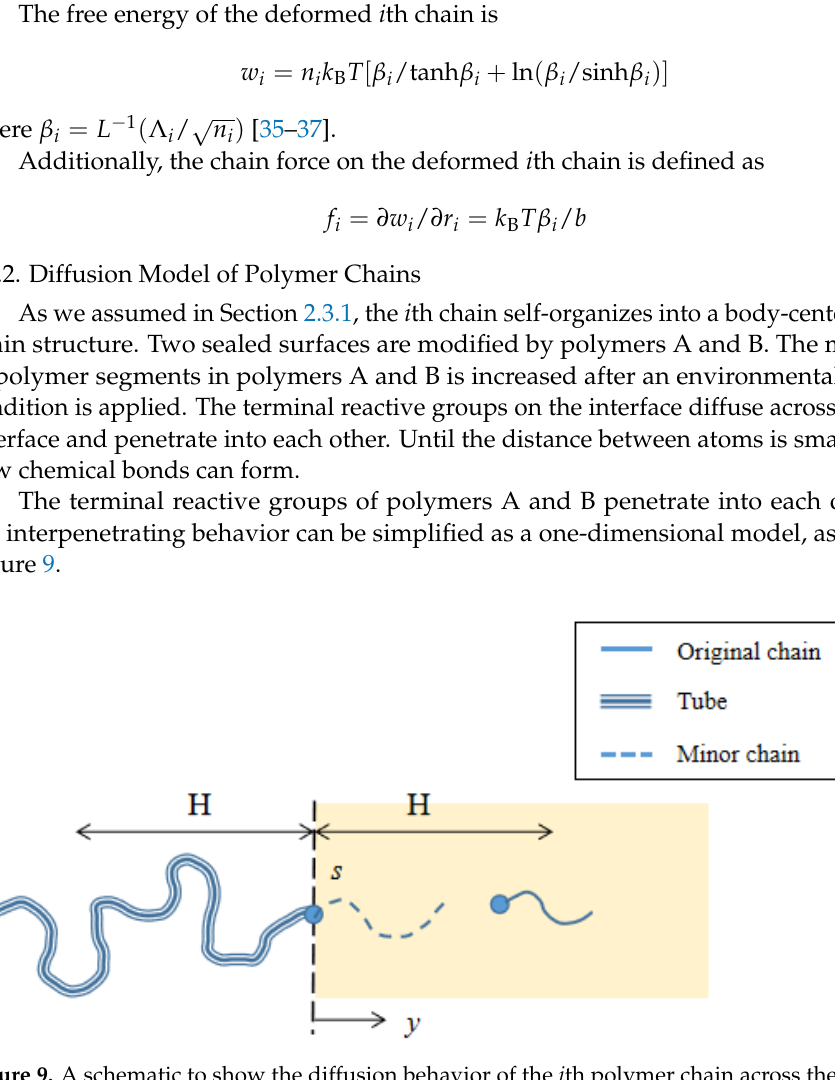
Figure 9. A schematic to show the diffusion behavior of the i th polymer chain across the interface.